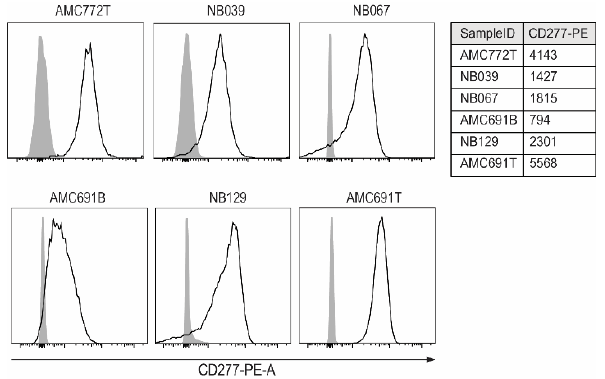
Figure 1. Expression of CD277 on neuroblastoma organoids. For each organoid, an unstained control served as a negative control (grey peaks). The table shows MFI of all samples for CD277PE.